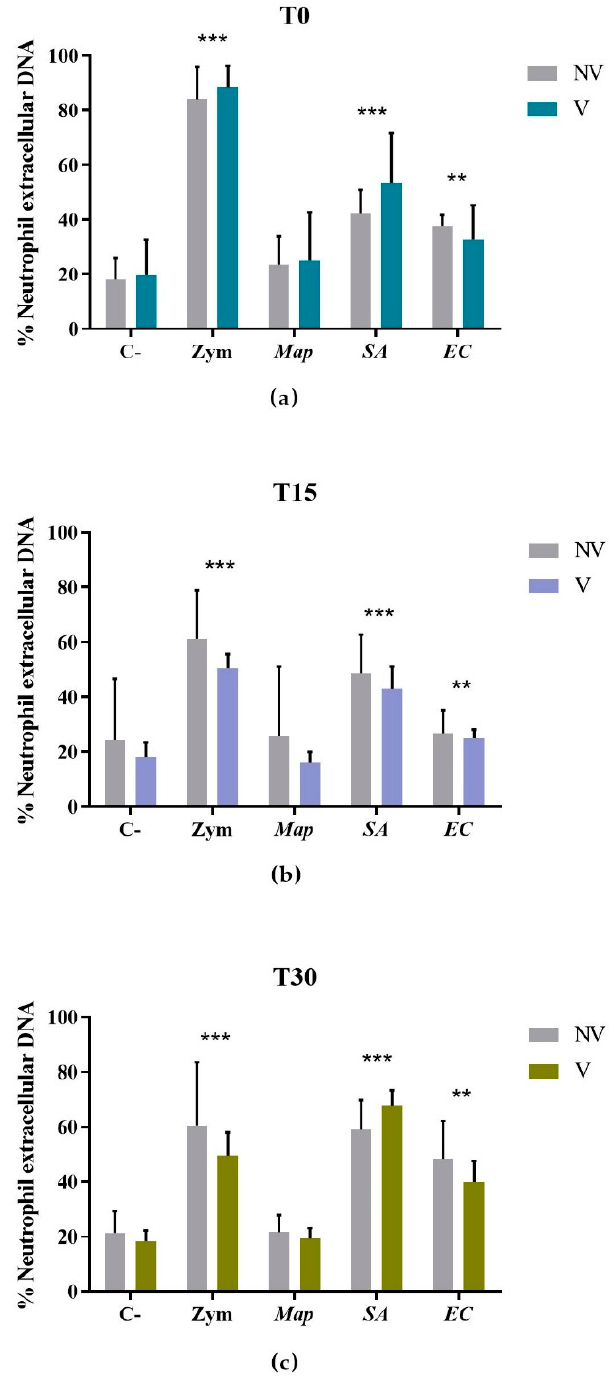
Figure 2. Percentage of extracellular DNA estimated by fluorometric quantification in non-vaccinated (NV) and vaccinated (V) groups. Bars and vertical lines represent mean percentage values and standard deviations, respectively, of non-stimulated (C-), Zymosan-stimulated (Zym), and Mycobacterium avium subsp. paratuberculosis- ( Map ), Staphylococcus aureus- ( SA ), and Escherichia coli ( EC )-infected neutrophils ( a ) before vaccination (T0) and ( b ) 15 (T15) and ( c ) 30 days (T30) post- vaccination. Significant differences estimated by the generalized linear model were expressed as * p < 0.05, ** p < 0.01, *** p < 0.001, and **** p < 0.0001.